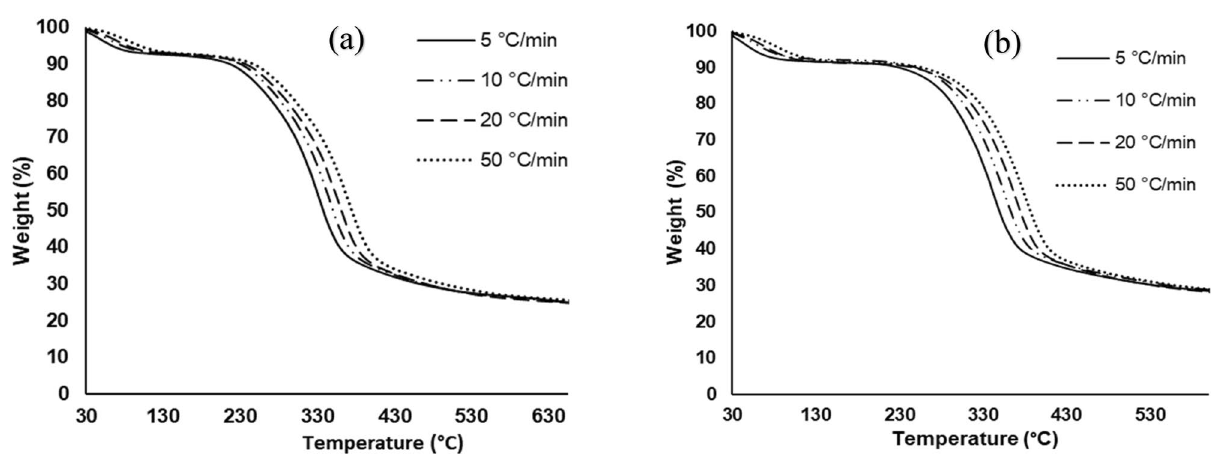
Figure 3. TGA thermograms at 5, 10, 20, 50 °C/min for ( a ) MH and ( b ) RP in N 2 pyrolytic